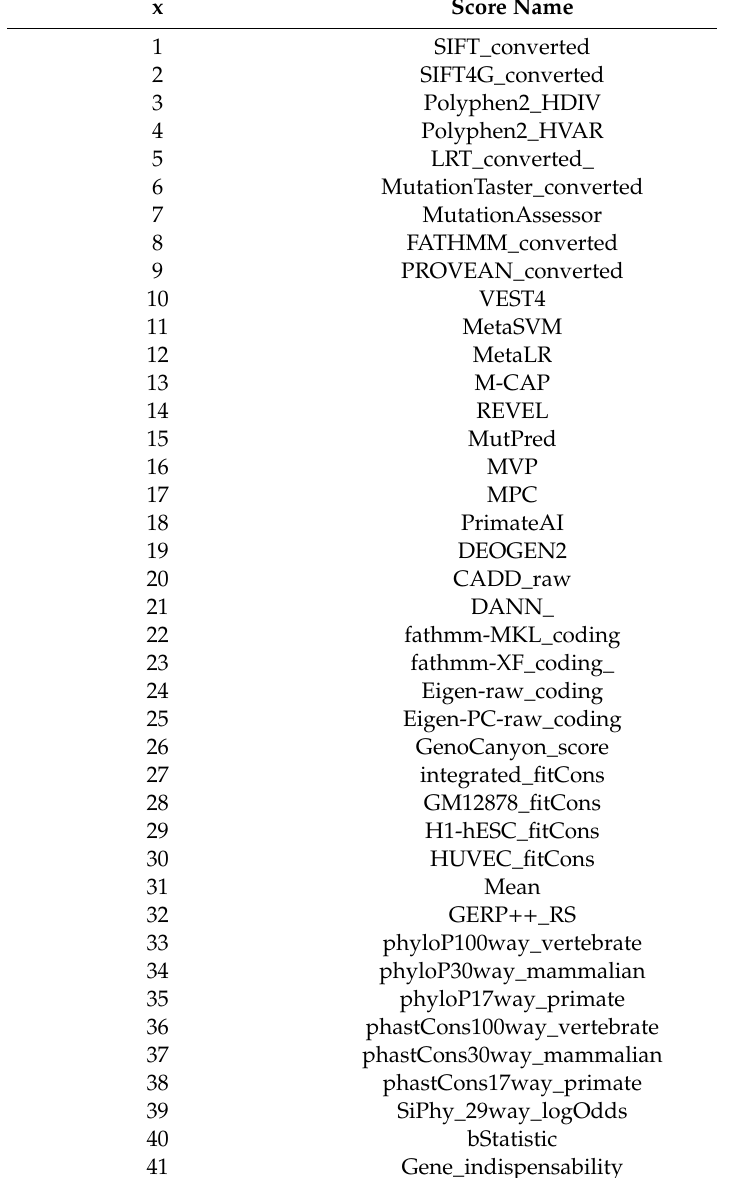
Table 1. List of the scores used